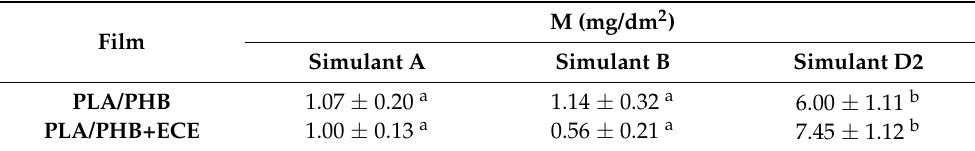
Table 5. Overall migration values obtained for the tested films in contact with food simulants A, B, and D2. Values expressed as mean ± standard deviation. Values reported different lowercase letters are significantly different ( p < 0.05). M (mg/dm 2 Film